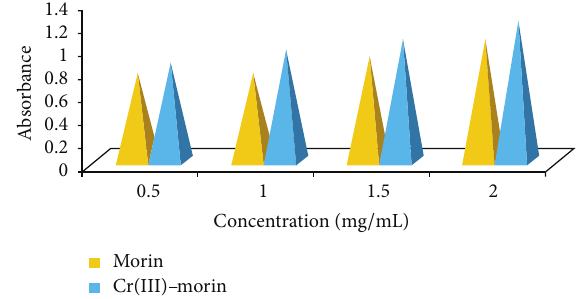
Figure 6: Ferric reducing potential of morin and its Cr(III)-morin